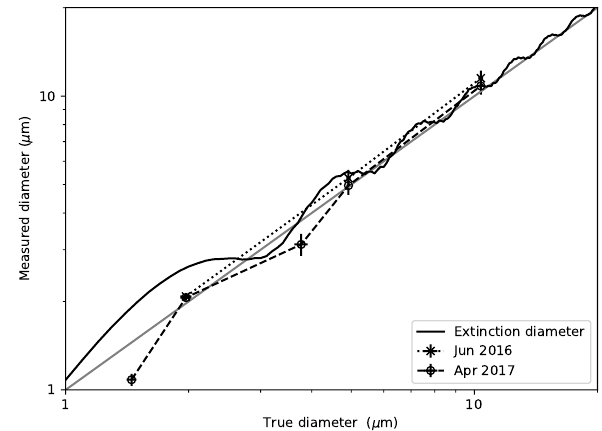
Figure 2. The diameter of standard polystyrene spheres measured by the Abakus as a function of the true diameter certified by the manufacturer (circles and dashed line), together with three of the same standards measured a year earlier (crosses and dotted line) and the optical extinction diameter of a sphere as a function of diameter (solid black curve). The grey line is where the measured and the true diameter are equal, to which the extinction diameter converges for large true diameters.